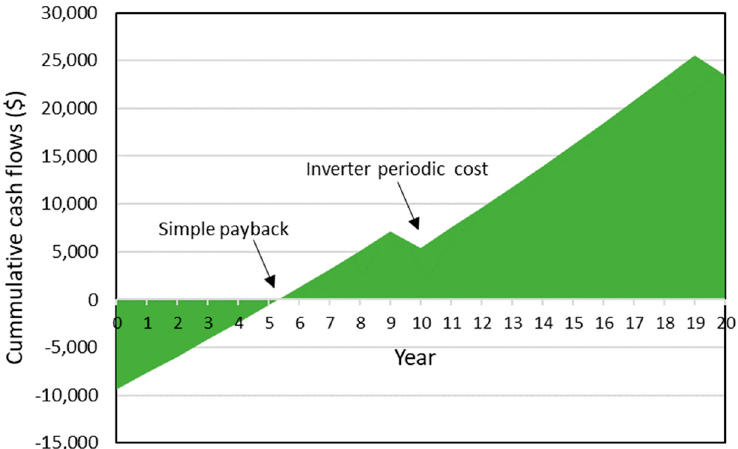
Figure 7. Cumulative cash flow and payback period.